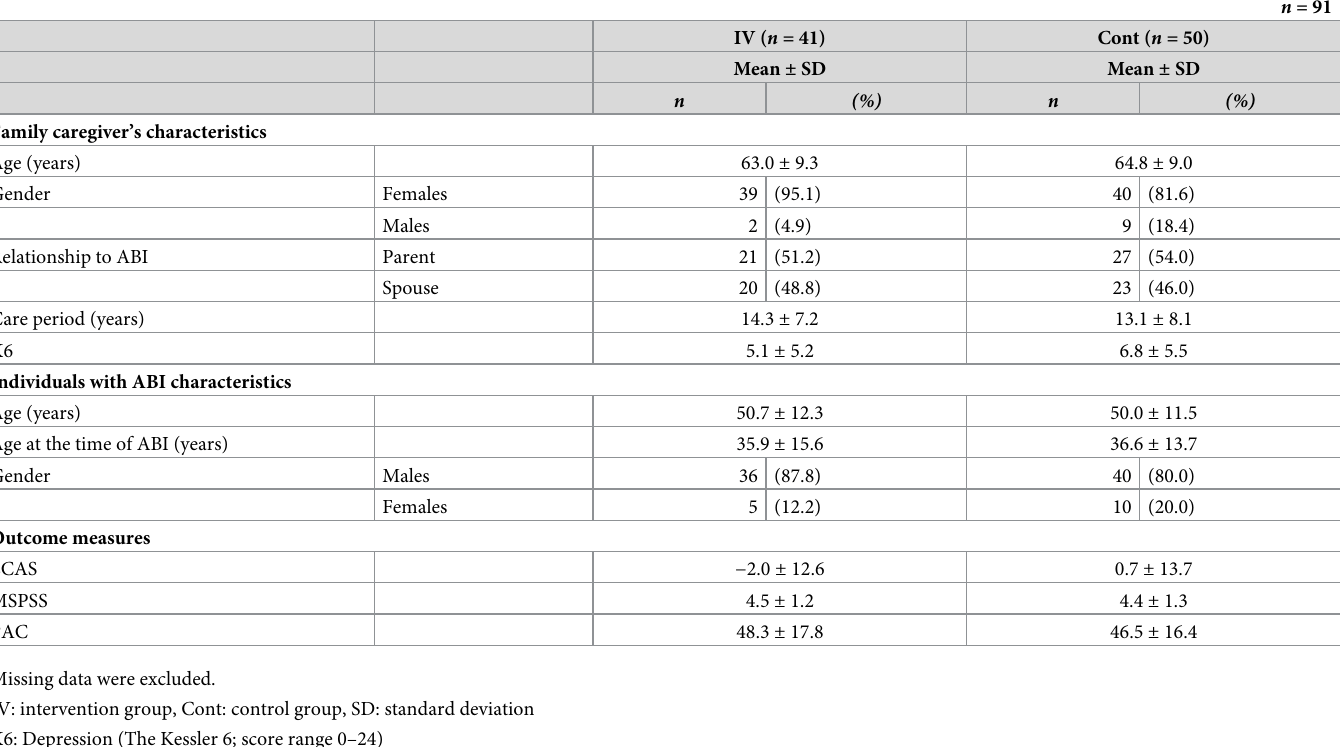
Table 1. Demographic characteristics and outcome measures at